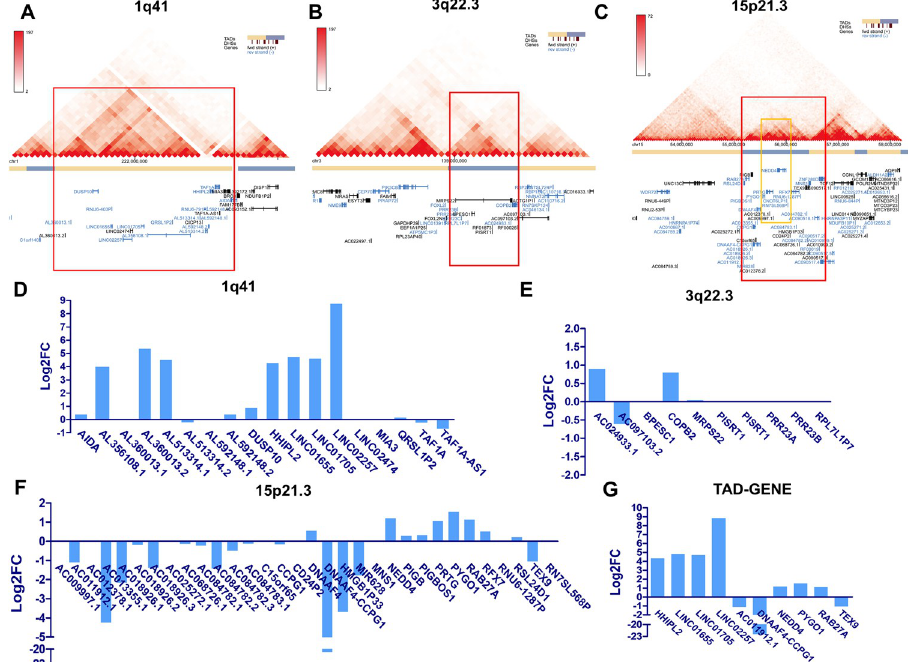
Fig 4. Differentially expressed RNAs in TADs of susceptibility loci. Differentially expressed RNAs in TAD (red outline) of locus 1q41 (A), locus 3q22.3 (B) and locus 15p21.3 (C). Detailed differentially expressed RNAs were listed in TAD of locus 1q41 (D), locus 3q22.3 (E) and locus 15p21.3 (F). Total ten significantly differentially expressed mRNAs/lncRNAs were obtained by screening through DERNAs with P < 0.05 and |log2FC| � 1 (G).